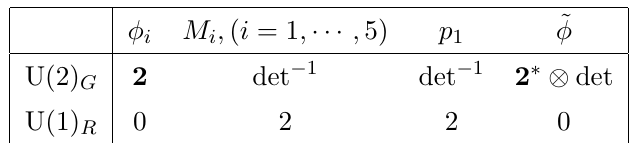
. S (cid:3) (cid:10)O (1) (cid:8)O (1)